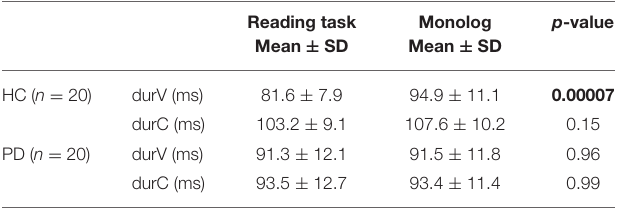
TABLE 2 | Mean duration of vocalic and consonantal portions in the two speaking tasks performed by PD and HC